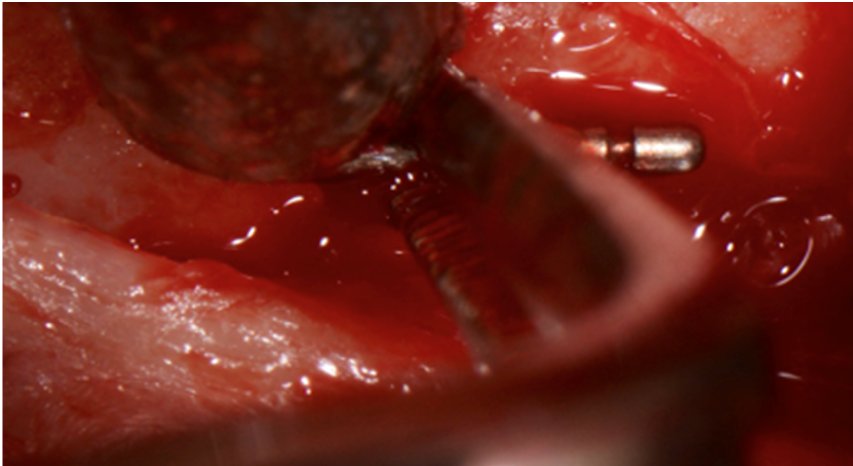
Figure 5. In situ image showing the removal of the broken periodontal probe tip from buccal, which was removed with pliers after careful luxation.